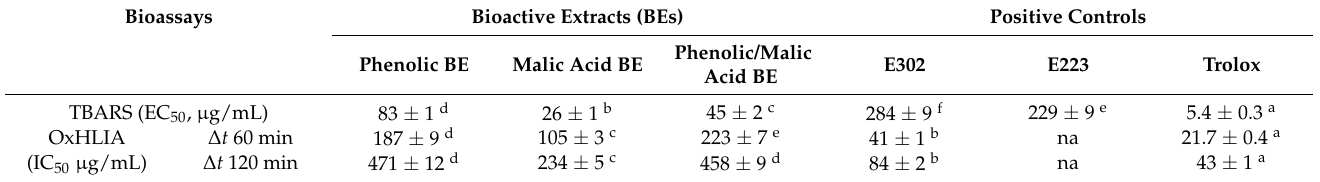
Table 5. Antioxidant activity of phenolic, malic acid, and phenolic/malic acid-enriched quince peel bioactive extracts (BEs) and positive controls (calcium ascorbate (E223), sodium metabisulfite (E302), and